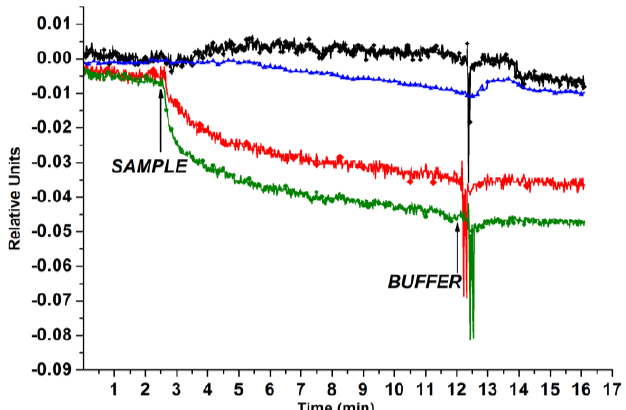
Figure 7. Results obtained upon the analysis of 10 plasma samples for the presence of CA 125 with the NR biosensor. The plasma samples were obtained from healthy volunteers (control samples; black and blue curves) and from ovarian cancer patients (sample # 60, red curve; sample #67, green curve). Experimental conditions: 1-mM potassium phosphate (KP) buffer, pH 7.4; V g = +50 V; V ds = 0.2 V. The total volume of the solution in the cell was 107 μL. Arrows indicate the addition of the analyzed plasma samples and washing with pure protein-free KP buffer.